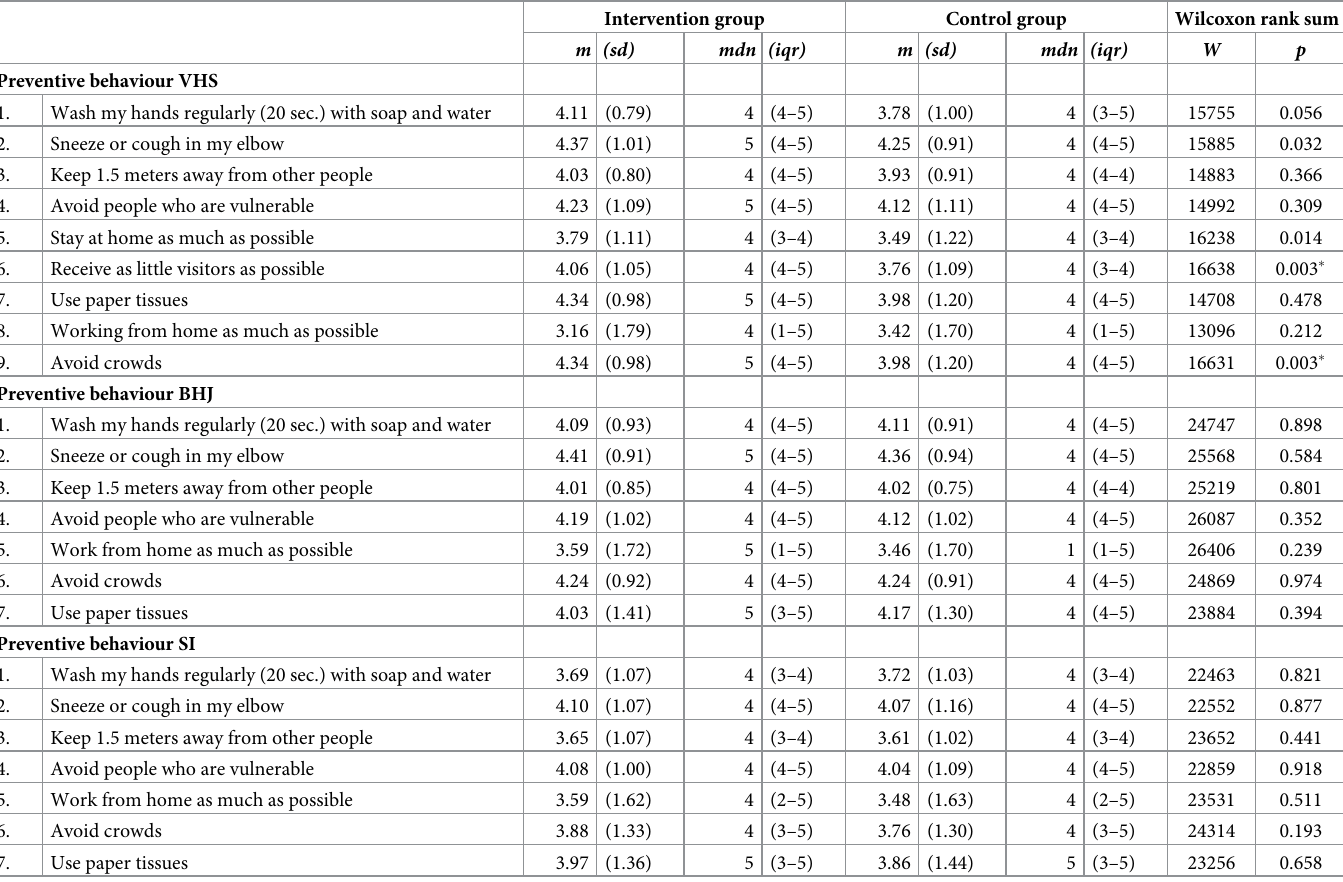
Table 4. Descriptive statistics of the behavioural measures for the three